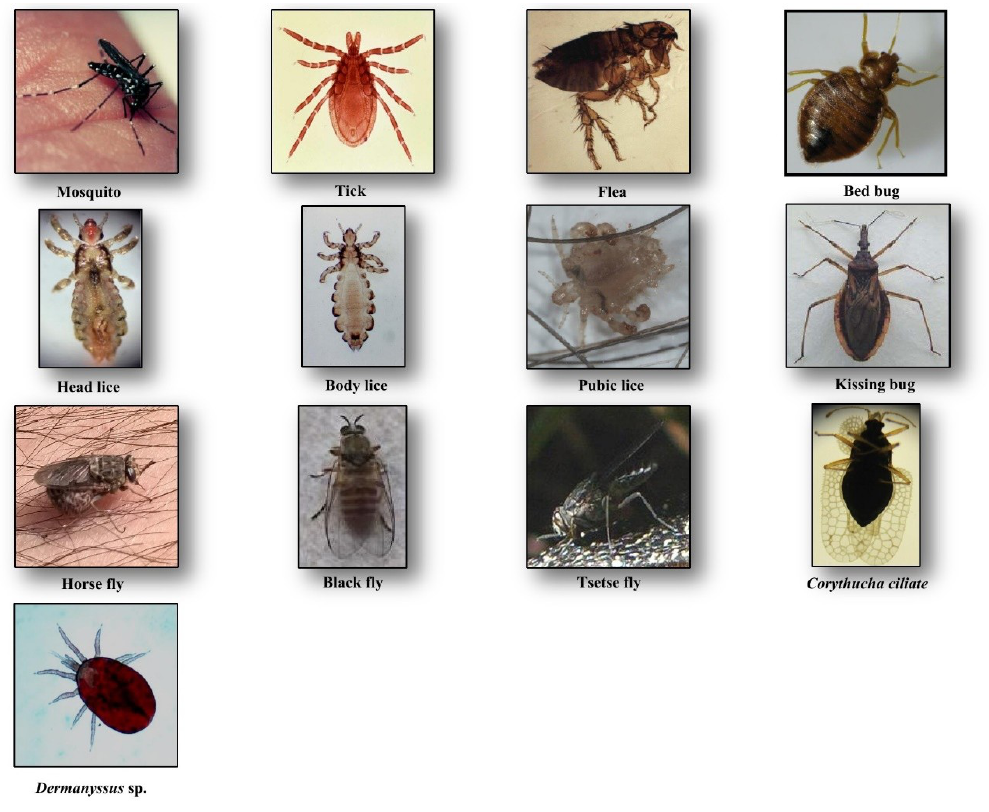
Figure 1. Hematophagous arthropods feeding on human blood.